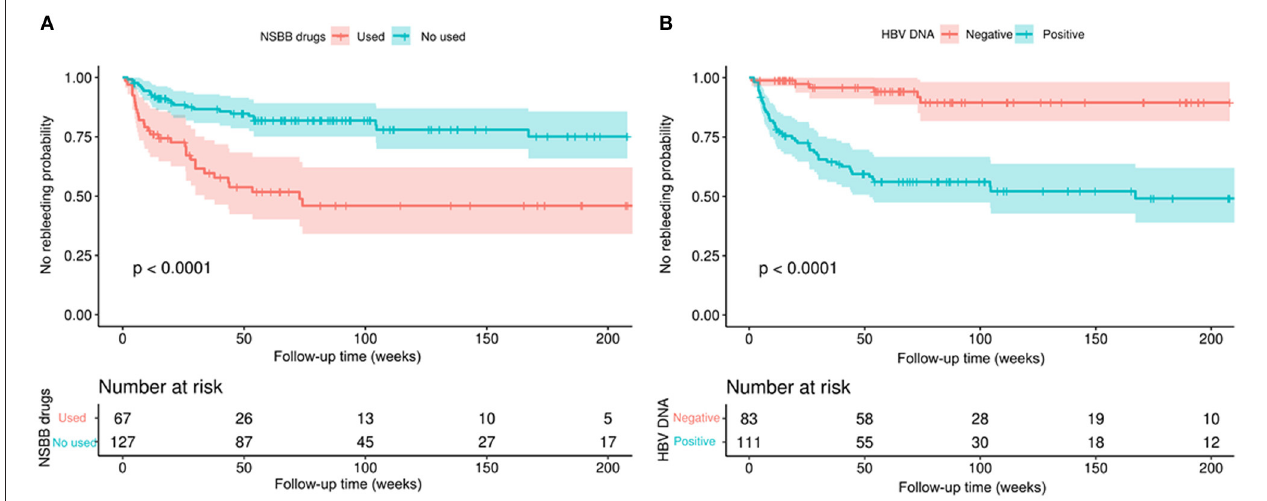
FIGURE 2 | Kaplan–Meier curves demonstrating rebleeding in patients with HBV-related cirrhosis according to different clinical characteristics. (A) According to whether NSBB drugs were used to compare the no rebleeding probability between the two groups. (B) According to whether HBV-DNA positivity was used to compare the no rebleeding probability between the two groups. p -values are from the log-rank